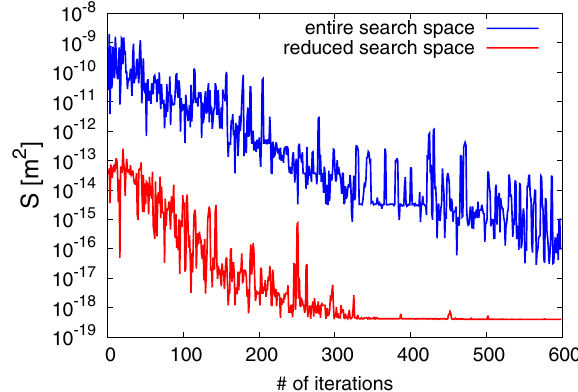
FIG. 14. Simulations over the entire search space (blue) and the reduced search space